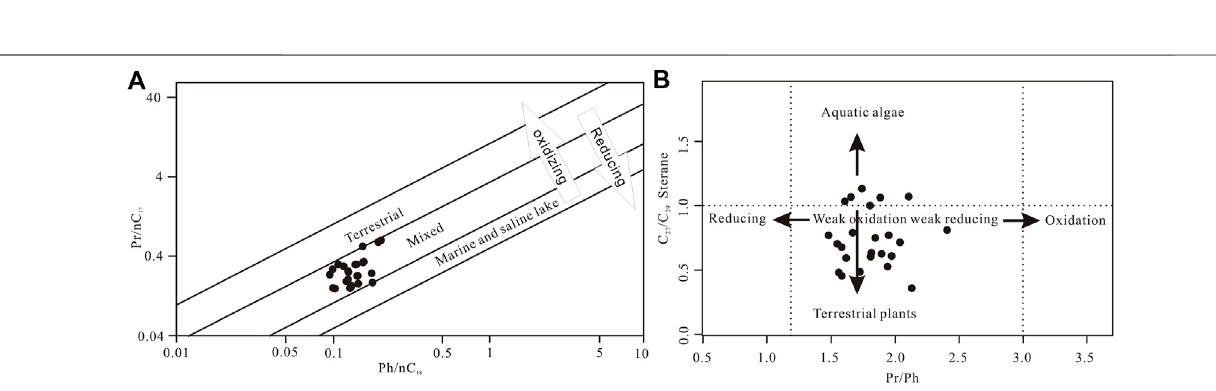
Frontiers in Earth Science |